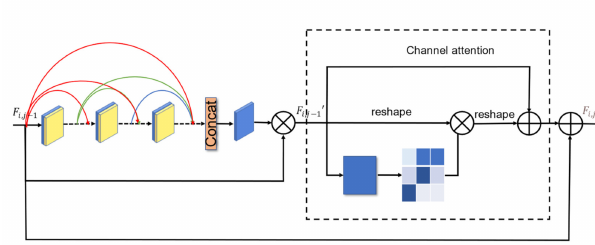
Figure 3. Residual dense block (RDB) architecture.